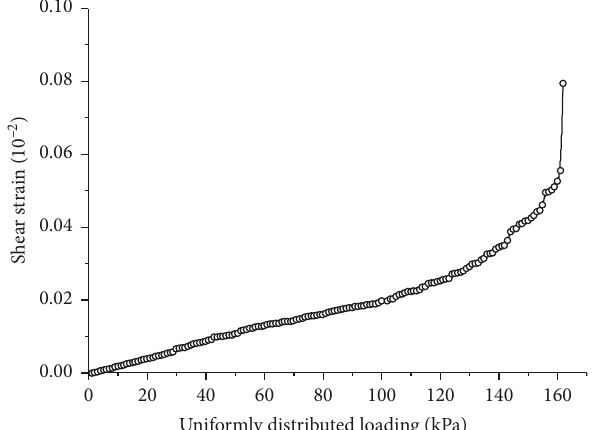
Figure 8: Changes of shear strain with increase of uniformly distributed